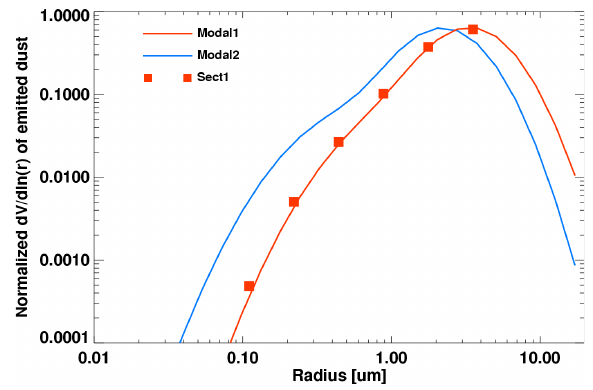
Fig. 2. Normalized volume size distributions of emitted dust from two cases for modal approach (Modal1 and Modal2) in Figure 2 Normalized volume size distributions of emitted dust from two cases for modal 8 MADE/SORGAM and one case for sectional approach (Sect1) in MOSAIC. approach (Modal1 and Modal2) in MADE/SORGAM and one case for sectional 9 approach (Sect1) in MOSAIC. 10